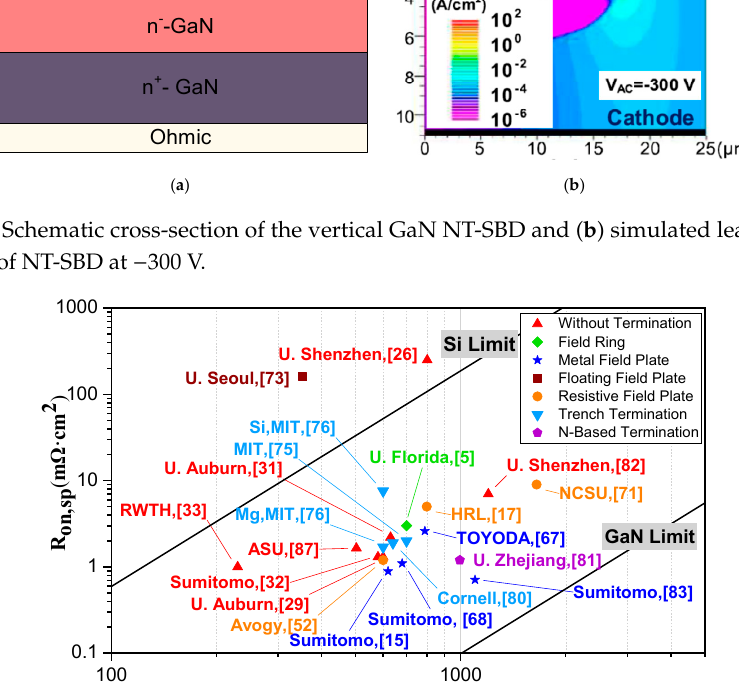
Figure 9. ( a ) Schematic cross-section of the vertical GaN NT-SBD and ( b ) simulated leakage current distribution of NT-SBD at − 300 V.